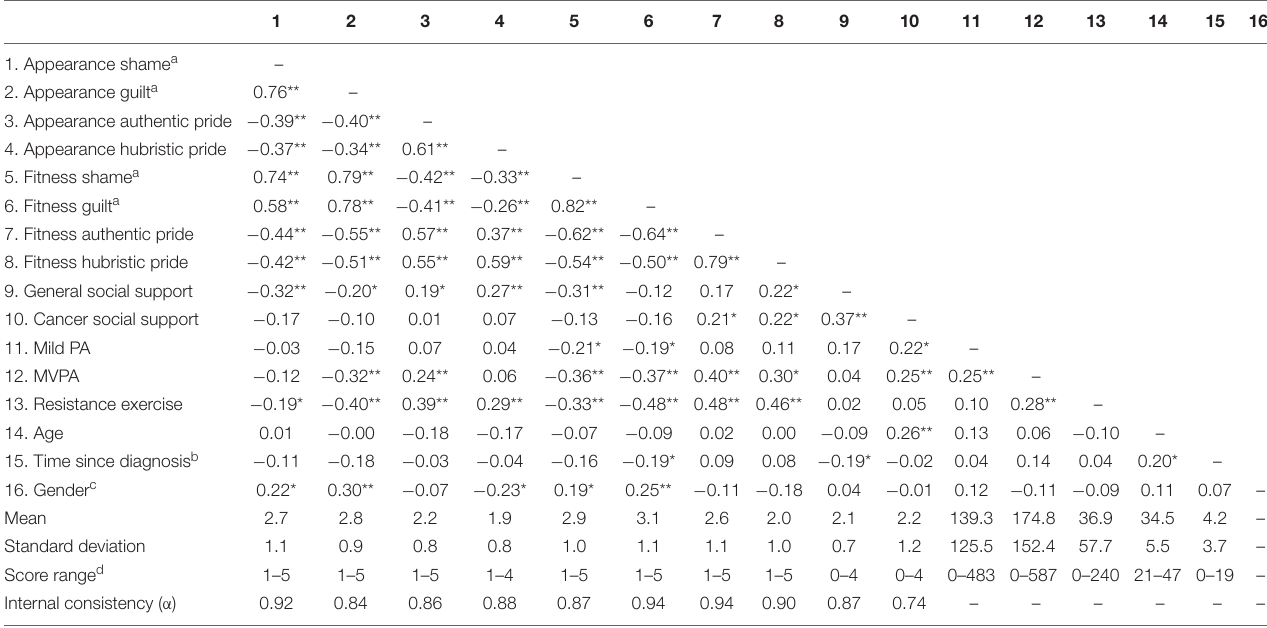
TABLE 2 | Descriptive statistics, bivariate correlations, and internal consistency for the main study variables ( n =